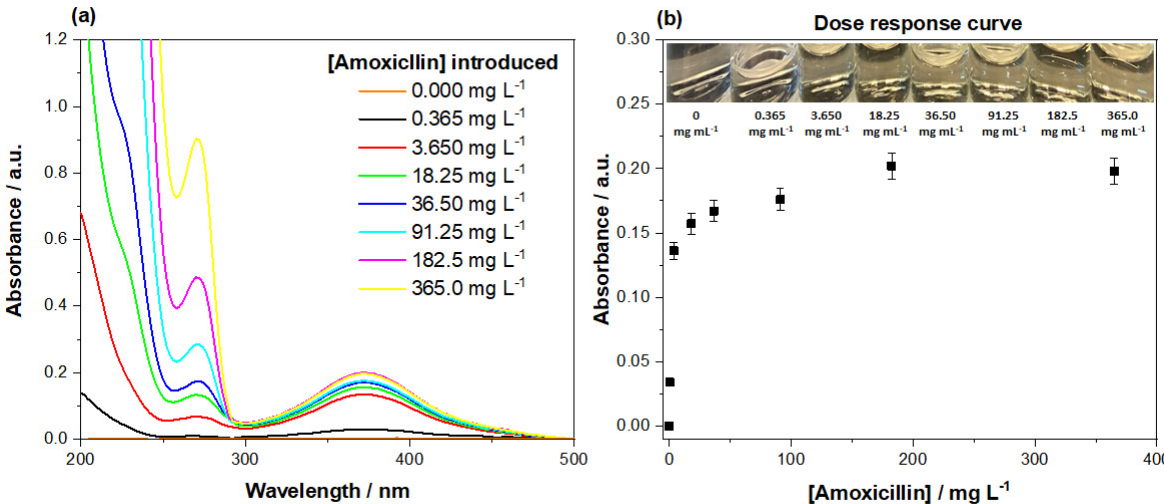
Figure 11. ( a ) The UV absorbance spectra of the filtrate collected from the incubation of differing concentrations of aqueous amoxicillin with the developed dye-loaded MIP, accompanied by ( b ) the plotted dose response correlating to the absorbance ( λ = 385 nm) of dye released and the concentration of amoxicillin present.